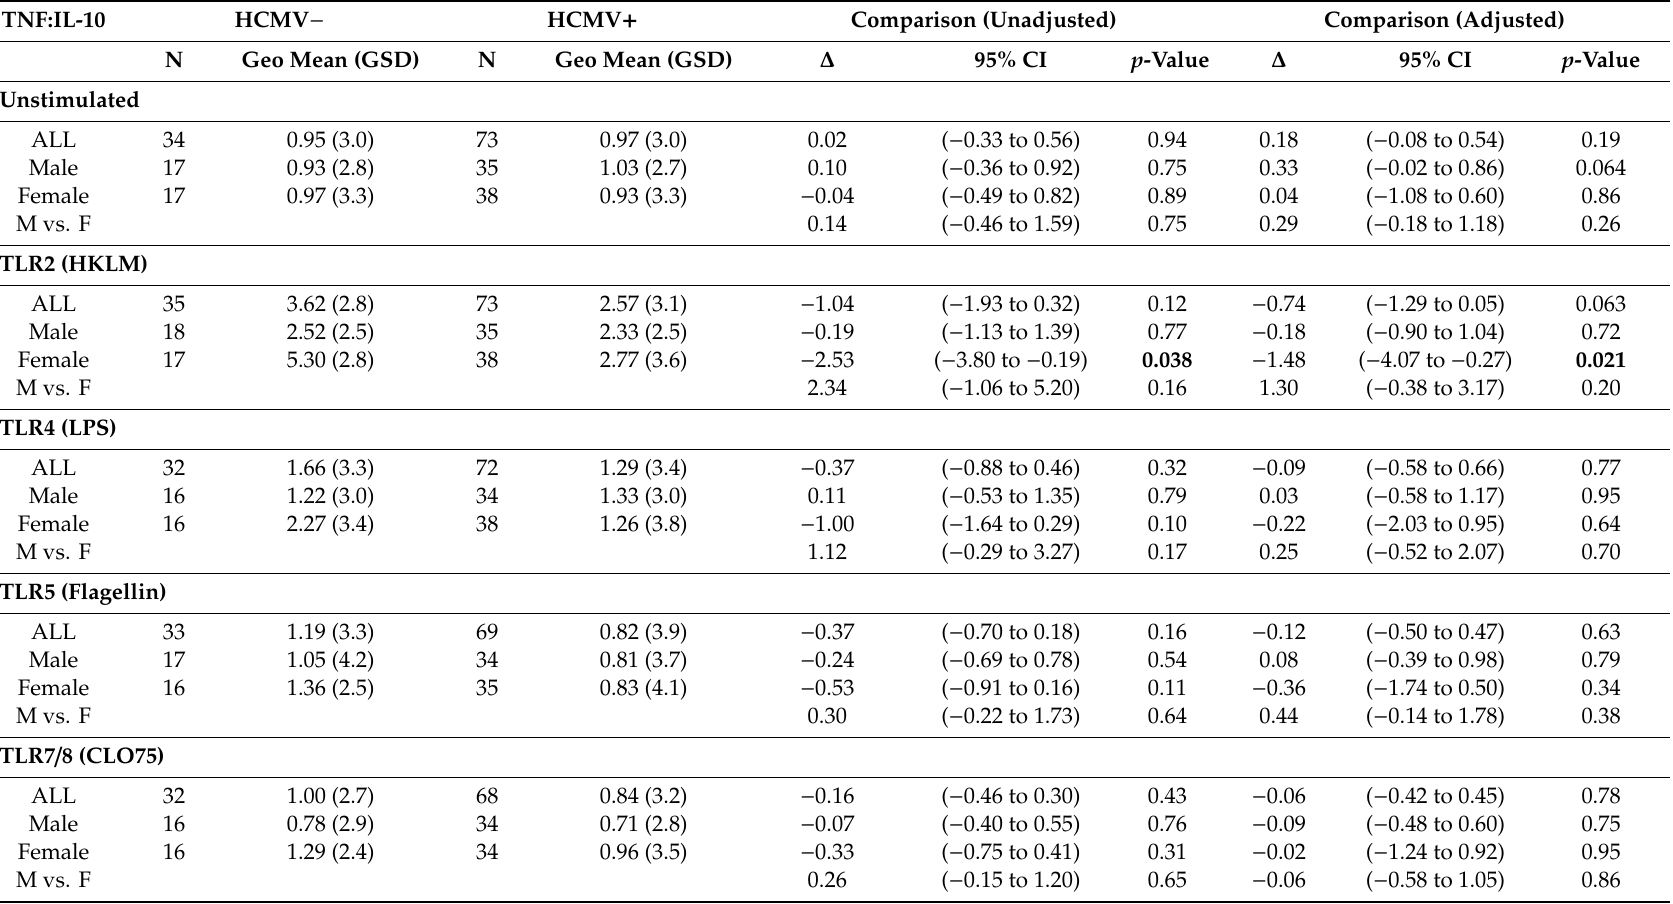
Table 7. E ff ect of HCMV infection TLR ligand-stimulated TNF- α :IL-10 ratio in culture supernatants by infant